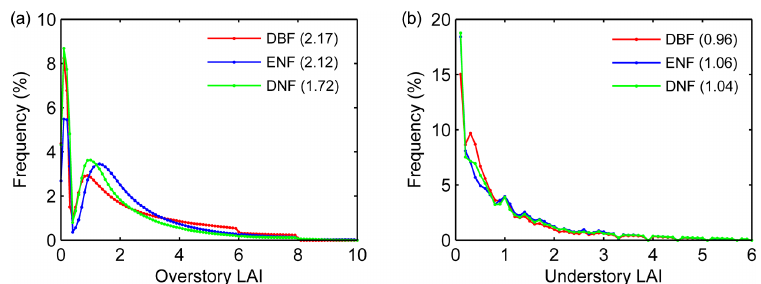
Figure 6. Histograms of the GLOBMAP overstory and understory LAI over the global forest area. (a) Forest overstory LAI (2008–2010) and (b) forest understory